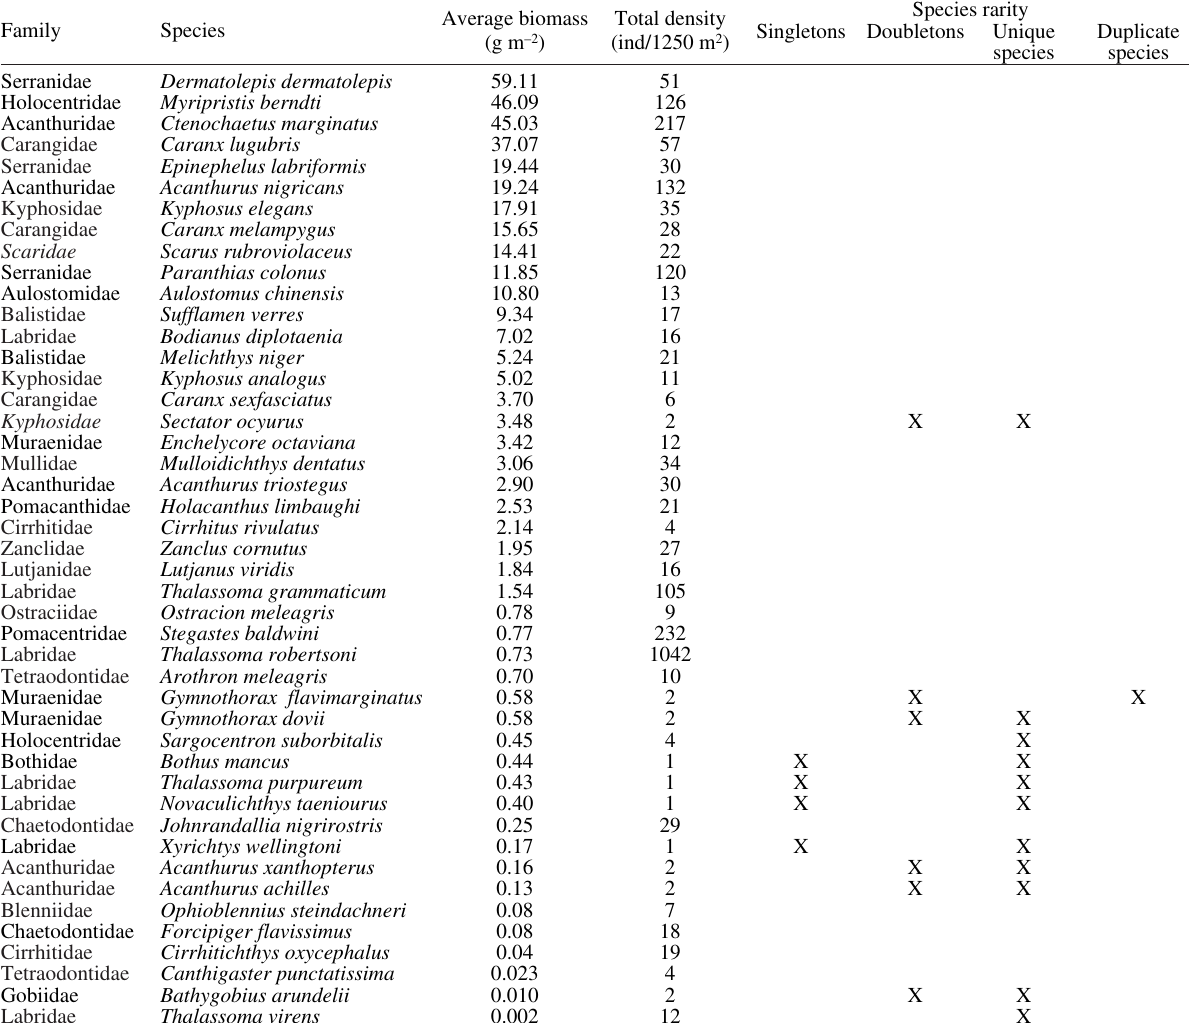
Table S1. − Reef fish species composition, abundance and rarity at Clipperton